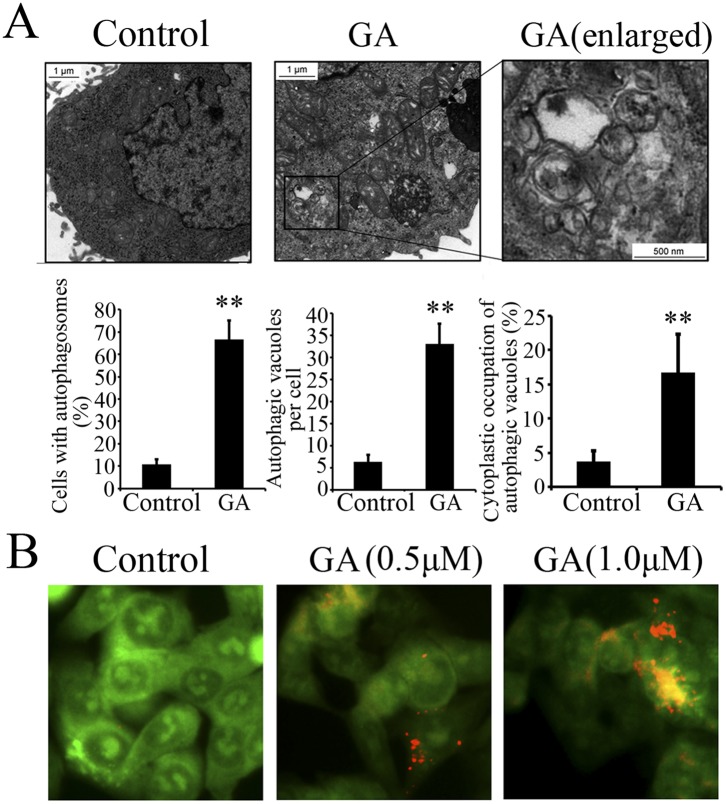
GA induced formation of autophagic vacuoles and AVOs in colorectal cancer cells.(A) Upper Panels. Representative transmission electron micrographs depicting ultrastructures of HCT116 cells treated with either DMSO (control, <0.1%) or 1 µM GA for 24 h. Lower panels. The cells with autophagic vacuoles were defined as cells that had five or more autophagic vacuoles. The percentage of the cells with autophagosomes and the average number of vacuoles per cell were analyzed from at least 100 randomly chosen TEM fields. Scale bars: 1 µm; 100 nm (indicated enlargements). (B) Acridine orange staining in HCT116 cells treated with DMSO (control, <0.1%), 0.5 µM GA or 1.0 µM GA for 12 h. All data are representative of three independent experiments. ** p<0.01.